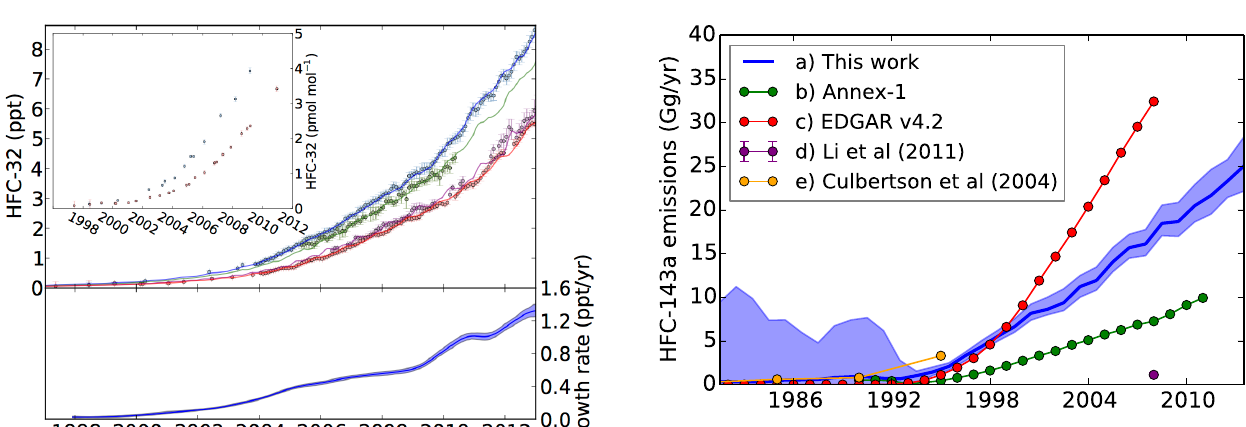
Figure 5. HFC-143a emissions estimates derived from AGAGE ob- servations (blue line and shading, indicating 1 σ uncertainty). The red line shows the global emissions estimates from EDGAR v4.2 and the green line shows the emissions reported to the UNFCCC. The purple point shows emissions estimated for East Asia by Li et al. (2011), and the orange points represents the mid-point of 5-year- average emissions estimated by Culbertson et al.